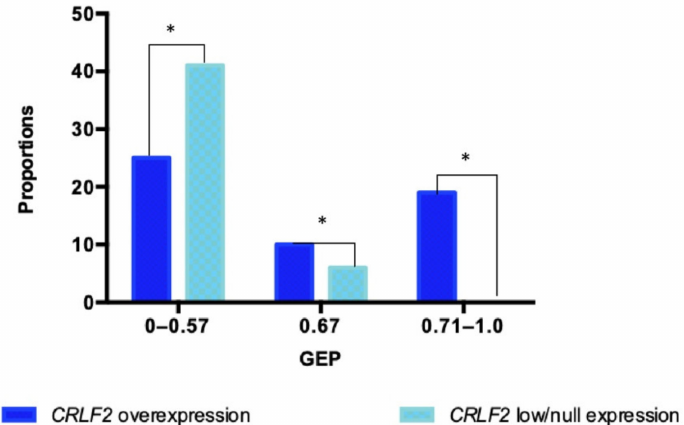
Figure 3. CRLF2 expression distribution between the different GEP coefficients. Different GEP coefficients were compared between patients with and low/null CRLF2 overexpression, statistic differences are presented (* p < 0.05 chi-square